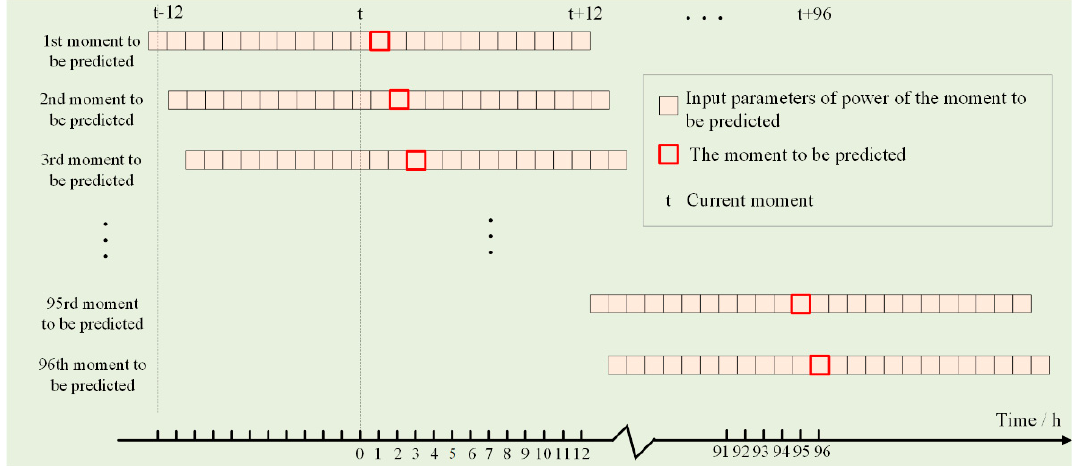
Figure 2. Input data for wind power prediction.